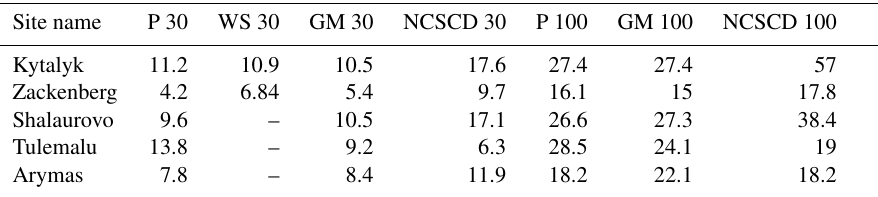
Table 2. Averaged SOC in kgm − 2 (30 or 100cm as indicated) for in situ (pedons – P), remotely sensed (ASAR GM – Global Monitoring mode; WS – Wide Swath mode) and the NCSCD soil data. Only points with available values for pedon as well as ASAR data are used.